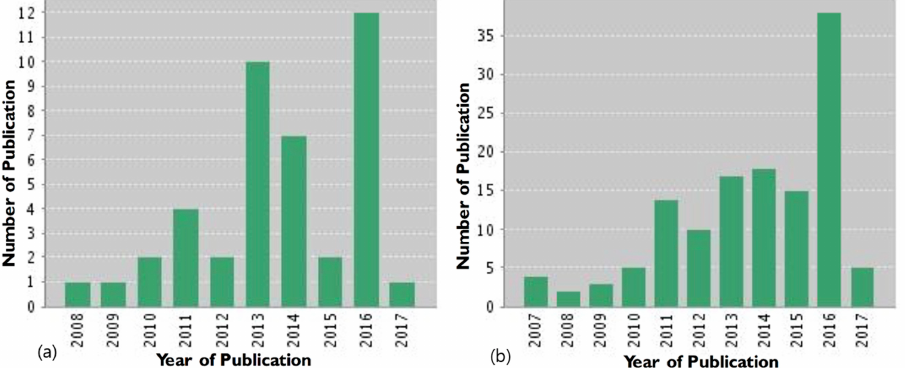
Figure 2 . ( a ) The number of scientific papers published over the past decade on internal stimuli-based gene delivery (source: ISI Web of Knowledge: The Thompson Corporation; search terms: “internal stimuli/gene delivery”; date of search: February 2017). ( b ) The number of scientific papers published over the past decade on internal stimuli-based drug delivery systems (source: ISI Web of Knowledge: The Thompson Corporation; search terms: “internal stimuli/drug delivery”; date of search: February 2017).